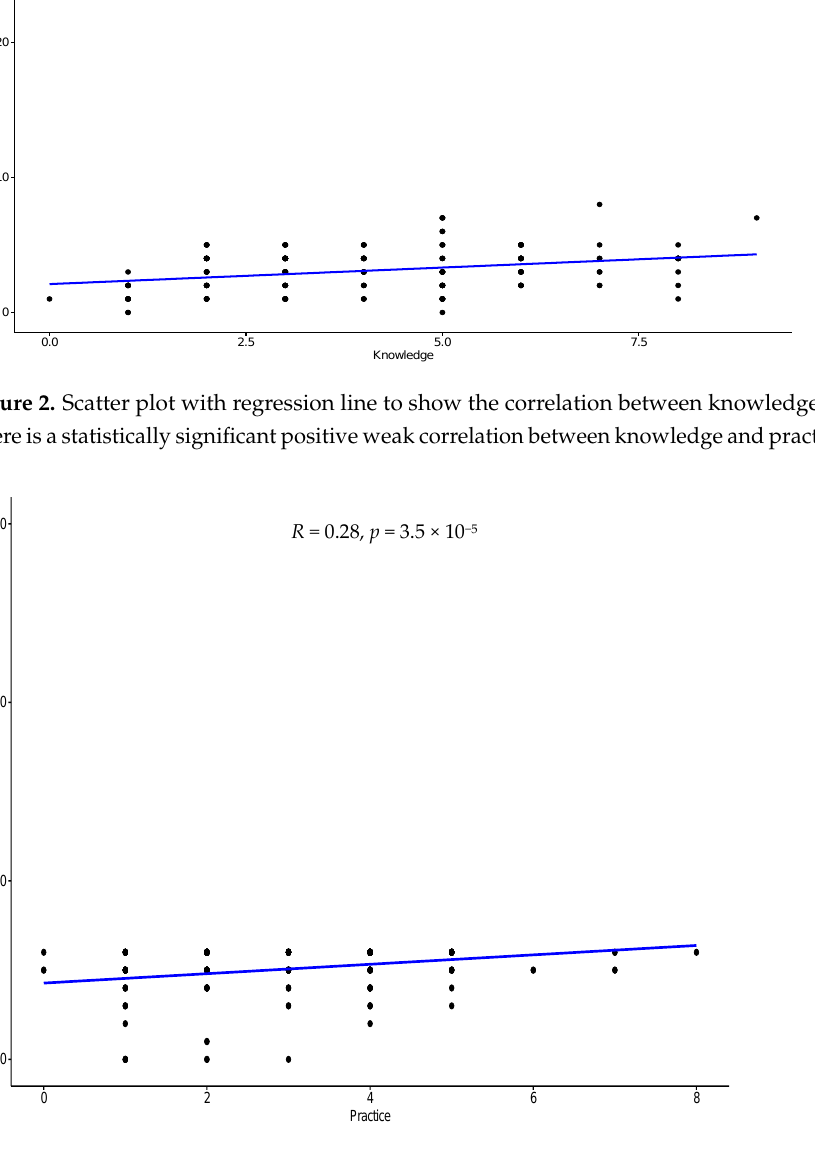
Figure 3. Scatter plot with regression line to show the correlation between attitude and practice. There is a statistically significant positive weak correlation between attitude and practice (R = 0.28).